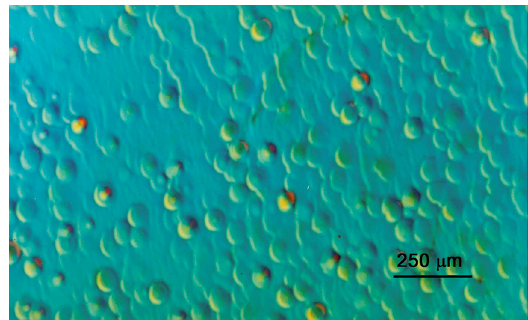
Figure 6: AlAs typical surface.